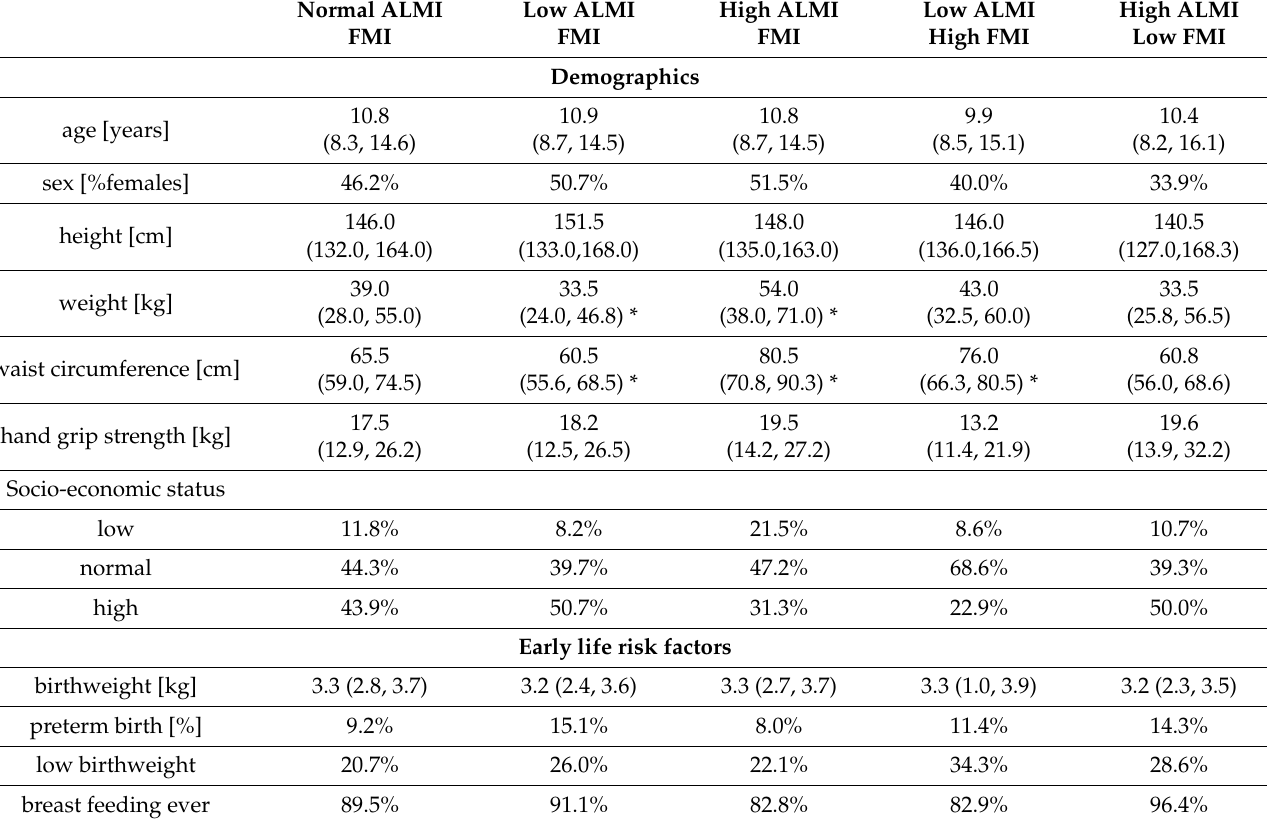
Table 3. Characteristics of body composition groups.